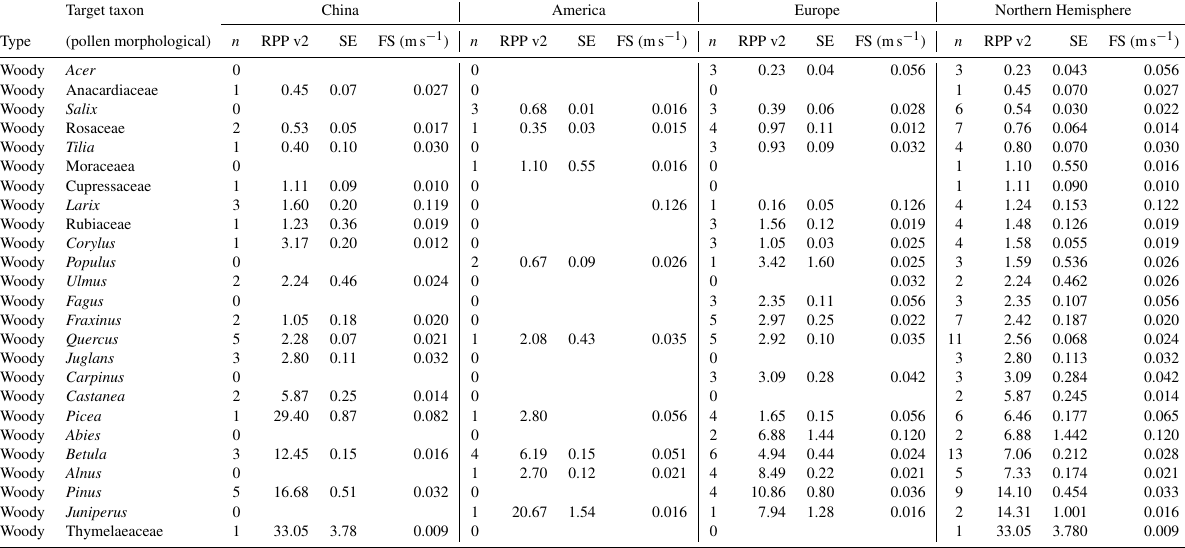
Table 5. Overview of continental and northern hemispheric relative pollen productivity (RPP) values for woody vegetation with their standard error (SE) (dataset v2) and fall speeds. All values are relative to Poaceae. See Table A1 for information on original RPP data, Table A4 for information on original fall speed values, and methods on the creation of dataset v2 (Wieczorek and Herzschuh, 2020, https://doi.org/10. 1594/PANGAEA.922661).